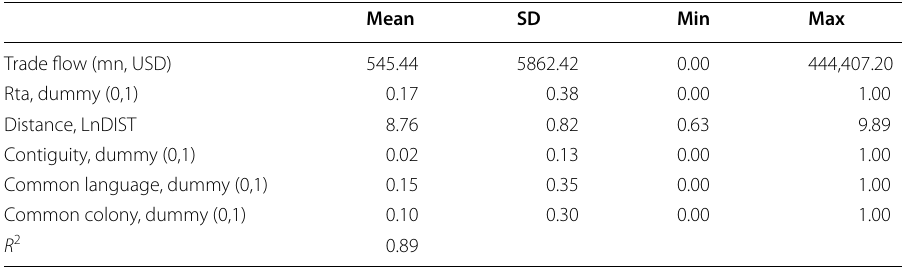
Table 1 Summary